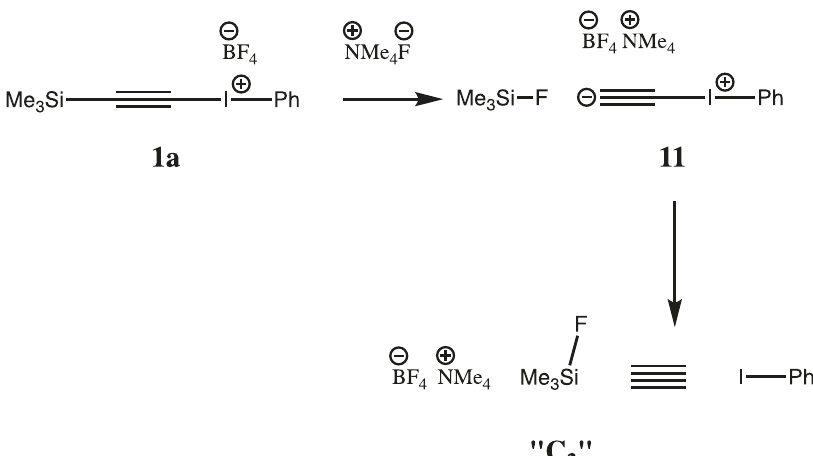
Fig. 1 Reaction scheme for proposed 1 chemical synthesis of singlet C 2 . The proposed 1 chemical synthesis of singlet C 2 , in which an alkynyl phenyl iodonium salt is treated with fl uoride anion to remove the trimethylsilyl group and generate an internal zwitterion 11 . This species is then proposed to fragment into iodobenzene and putative singlet C 2